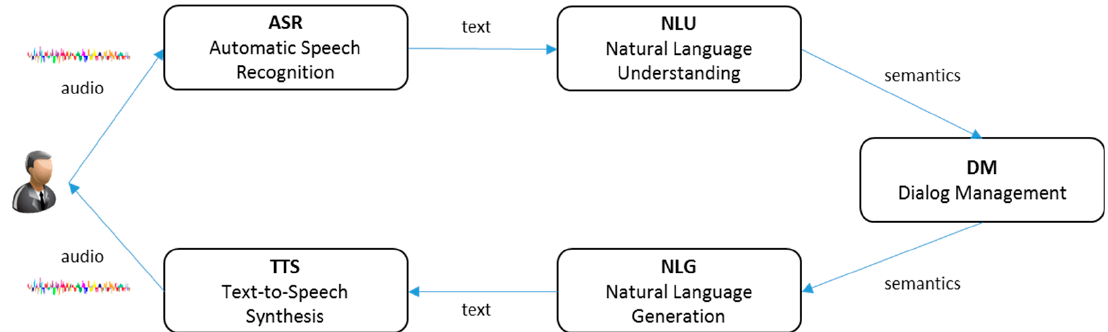
Figure 1. Overview of task-oriented dialog system.